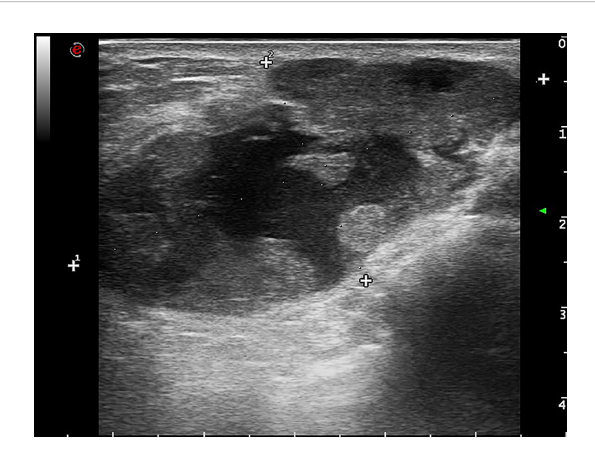
FIGURE 1 Breast imaging. Ultrasonography shows cystic solid compound echo with a size of 56*44*27mm of the left breast.